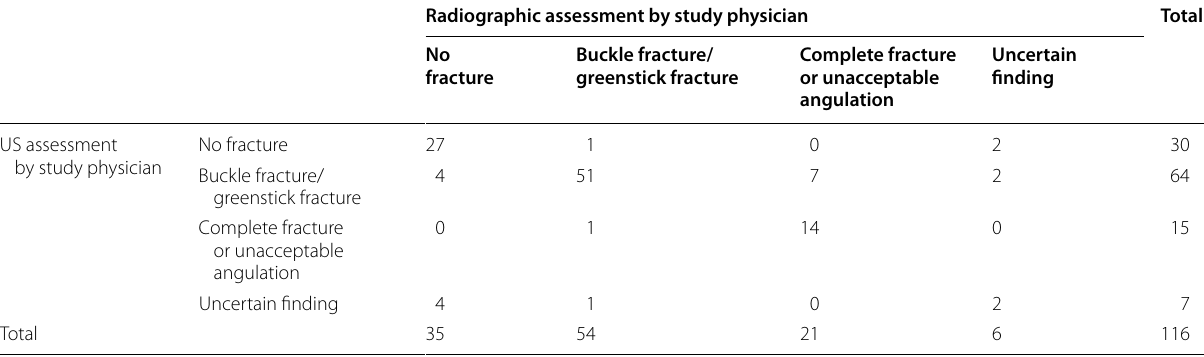
The radiologist’s interpretation is not shown here